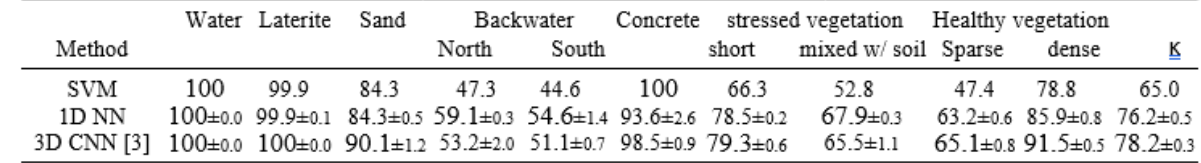
Table 2: Classification scores for three ML